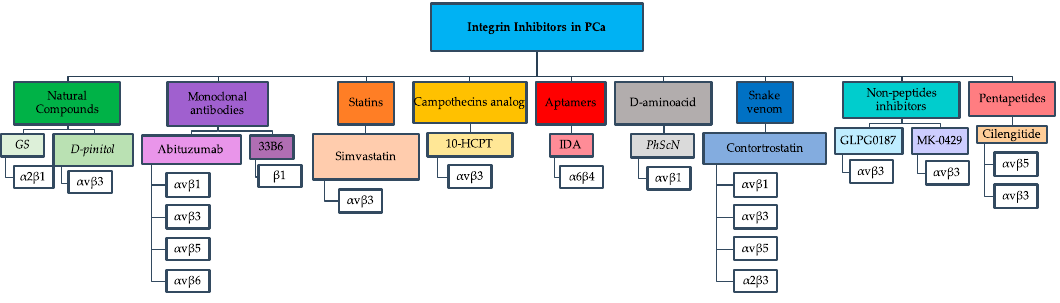
Figure 1. Representative flowchart of integrin inhibitors used against PCa. The flowchart depicts seven different groups of integrin inhibitors with their respective integrin receptors that were studied as drug targets in PCa.